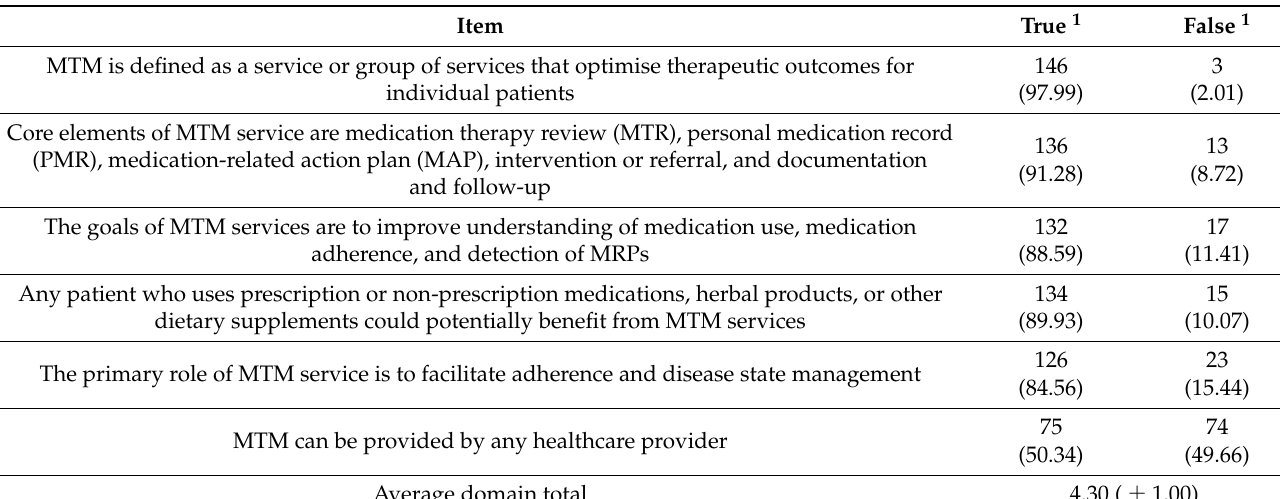
Table 3. Participant medication therapy management (MTM) knowledge ( n = 149).